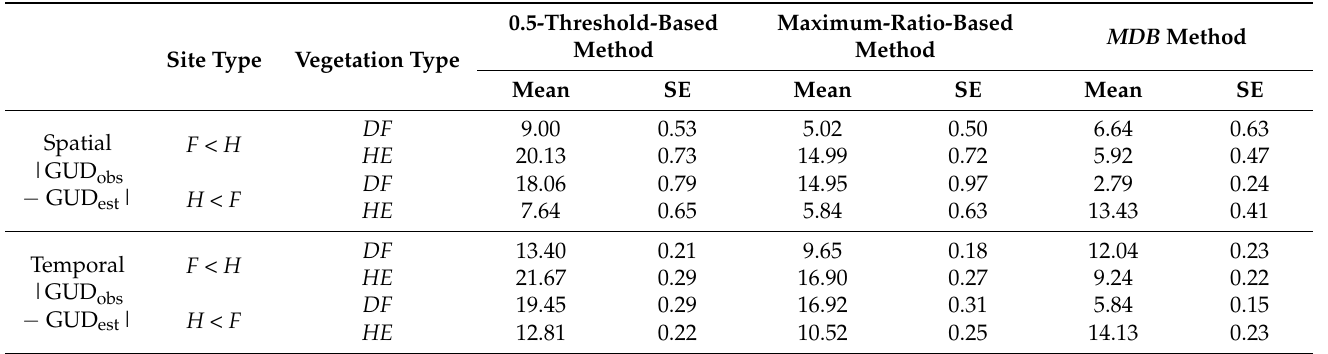
Table 1. Mean absolute differences between observed GUD of deciduous forest and herbage, and estimated GUD (|GUD obs − GUD est |) (Mean ± SE) derived from three predicted methods.